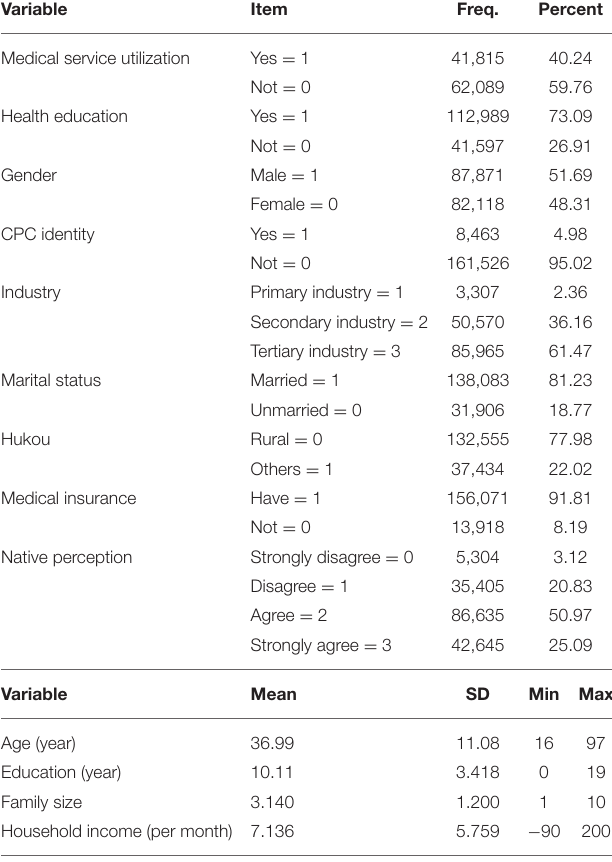
TABLE 1 | Descriptive statistics.